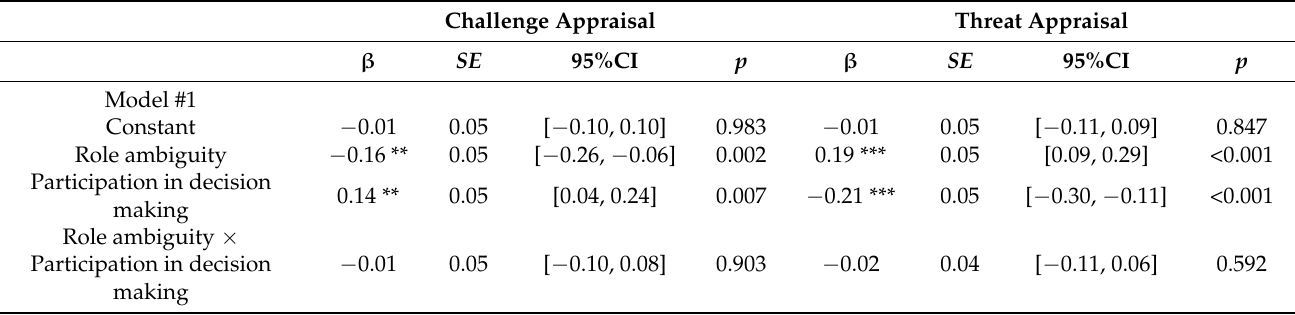
Table 7. Linear model of predictors of nurses’ challenge and threat appraisal of role